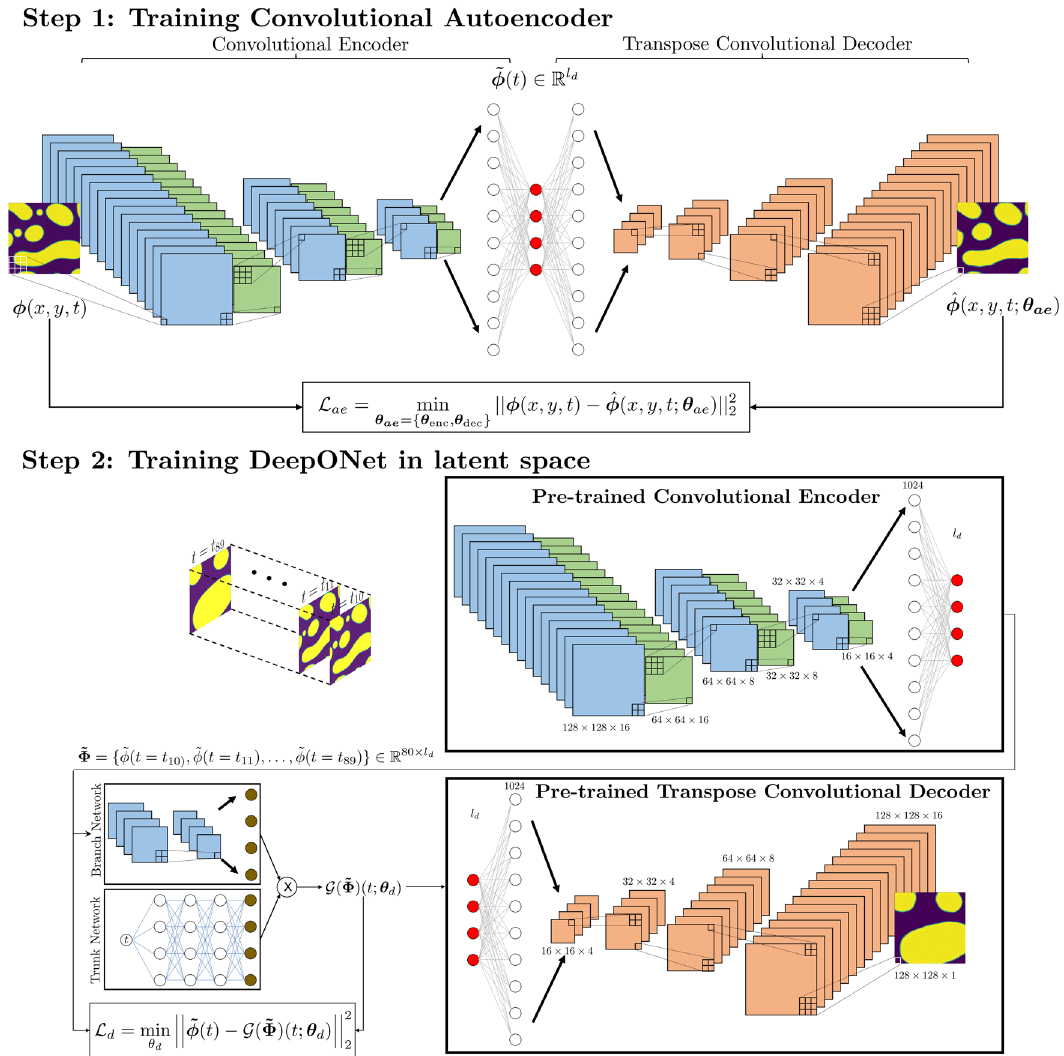
Fig. 1 Schematic representation of DeepONet with convolutional autoencoder. Step 1 involves training of the convolutional autoencoder to minimize L ae . The encoder learns a suitable transformation from the high-dimensional microstructure to a low-dimensional latent space through a series of convolution (blue layers) and MaxPooling (green layers) operations. The decoder remaps the latent representation of the microstructure back to the original, real space by performing transpose convolution (orange layers) operations. A detailed description of the architecture is provided in Table 1. In step 2, we train the DeepONet in the latent space to minimize L d . The entire history of 80 steps is encoded by the pre-trained convolutional encoder as ~ Φ . DeepONet learns to predict ~ ϕ ð t Þ at any desired time t , fed to the trunk network. The latent representation of the microstructure predicted by DeepONet is then re-mapped back to the primitive space by the transpose convolutional